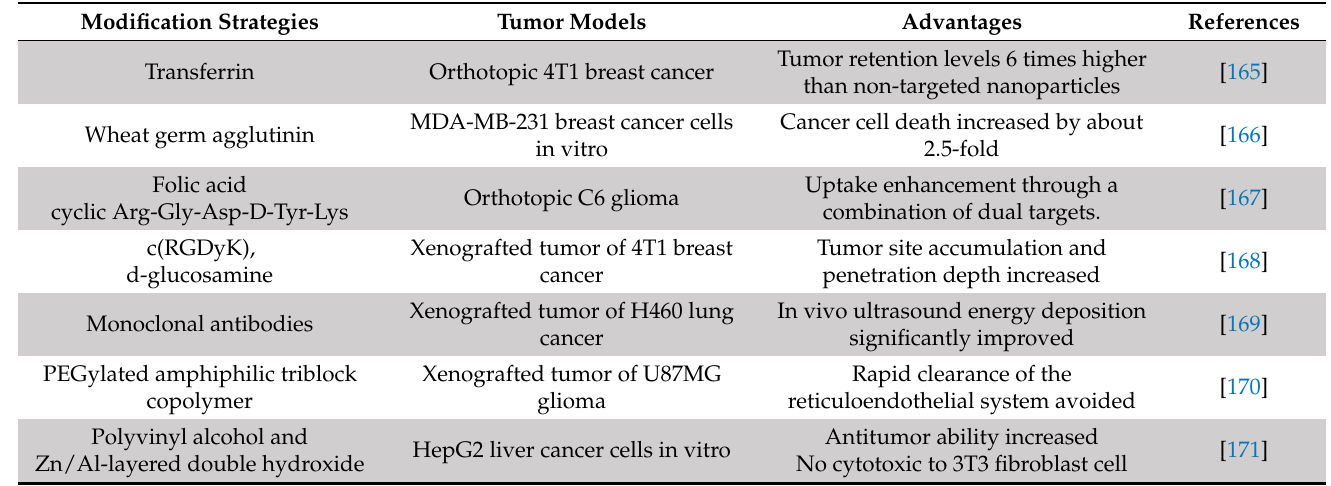
Table 2. Modification strategies for enhancing active tumor targeting of